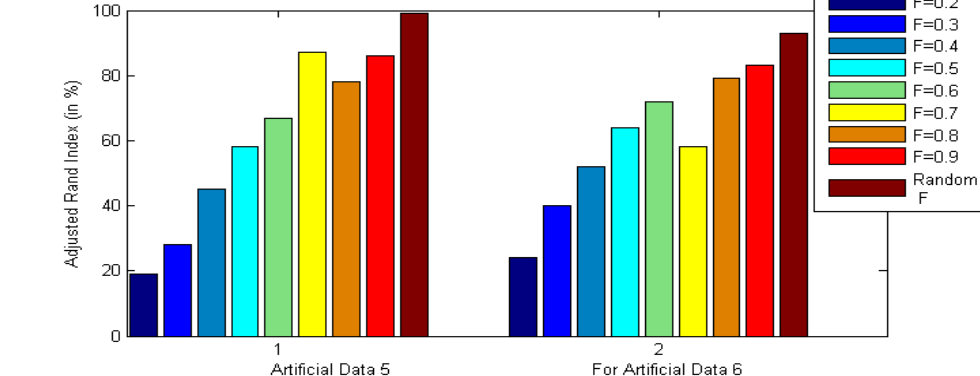
Figure 2. Final clustering result for artificial datasets 5 and 6 with MODE for different settings of scale factor F .